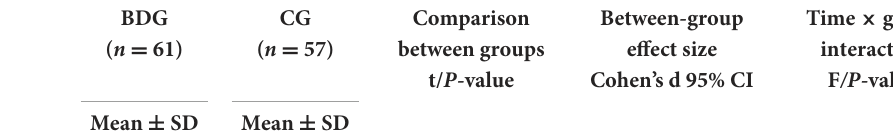
TABLE 4 The comparison of the single indicator constructing health-related physical fitness, cardiopulmonary fitness, handgrip strength and body composition between two groups. Outcome BDG